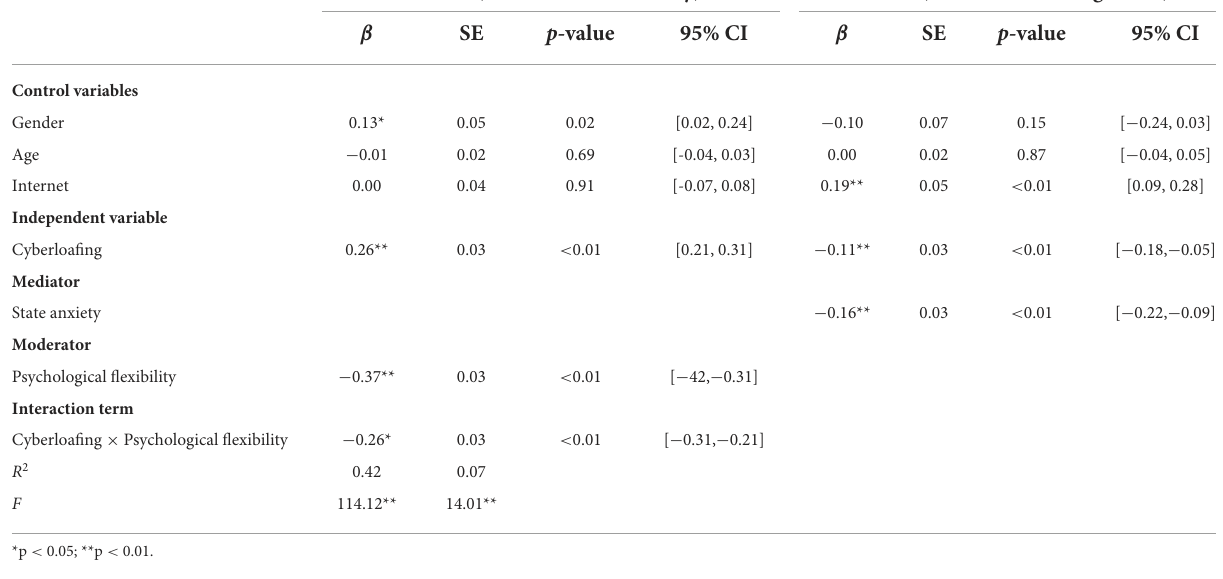
TABLE 3 Moderated mediation effect analysis. Model1 (criterion: state anxiety) Model2 (criterion: meaning of life)